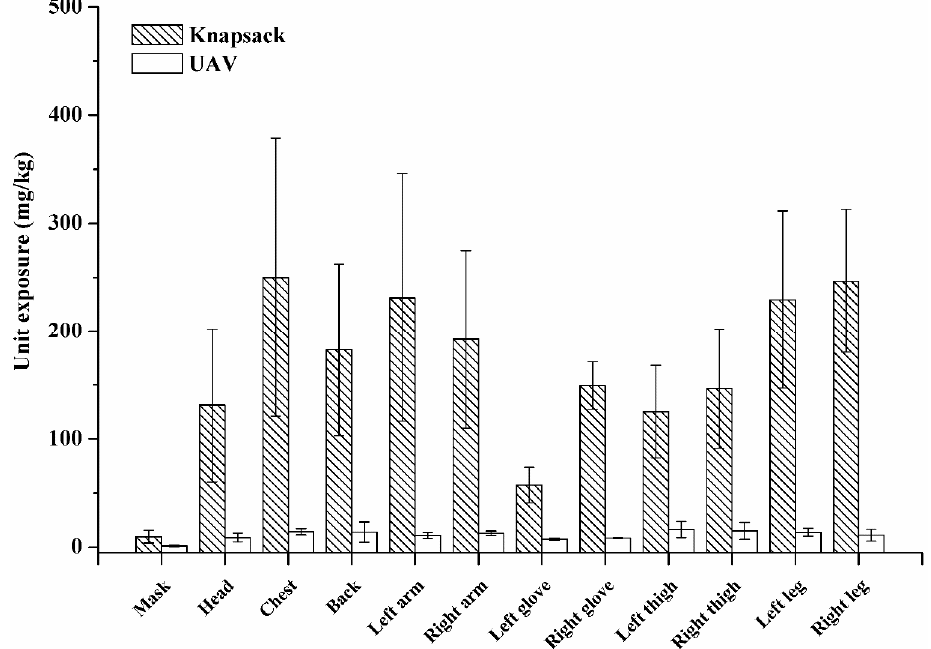
Figure 4. Potential dermal exposure of operators to Allure Red sprayed by knapsack electric and UAV sprayers ( n = 6 for knapsack spraying including two operators and n = 3 for UVA spraying).